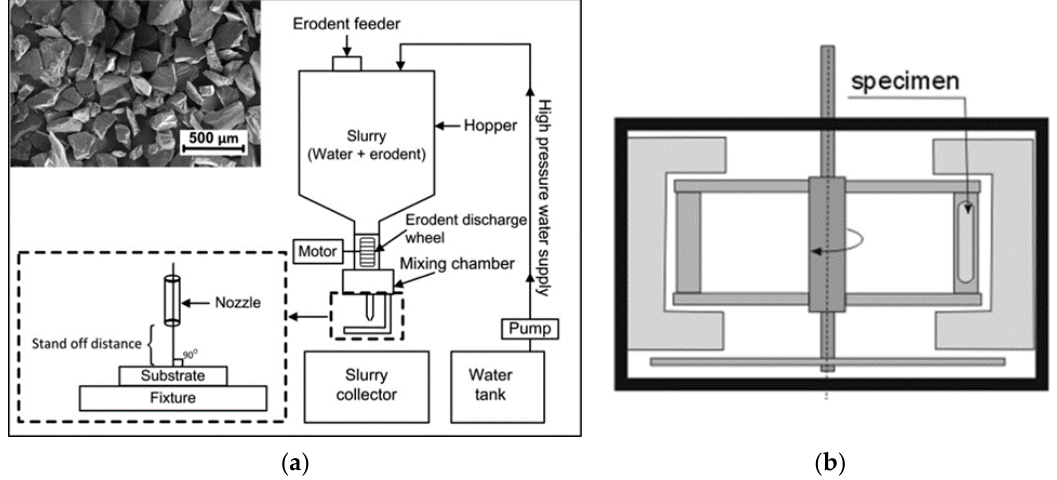
Figure 9. The examples of ( a ) a jet type apparatus, reprinted from Wear , Reference [108], with permission from Elsevier and ( b ) a slurry pot, reprinted from Engineering Failure Analysis, Reference [109], with permission from Elsevier.